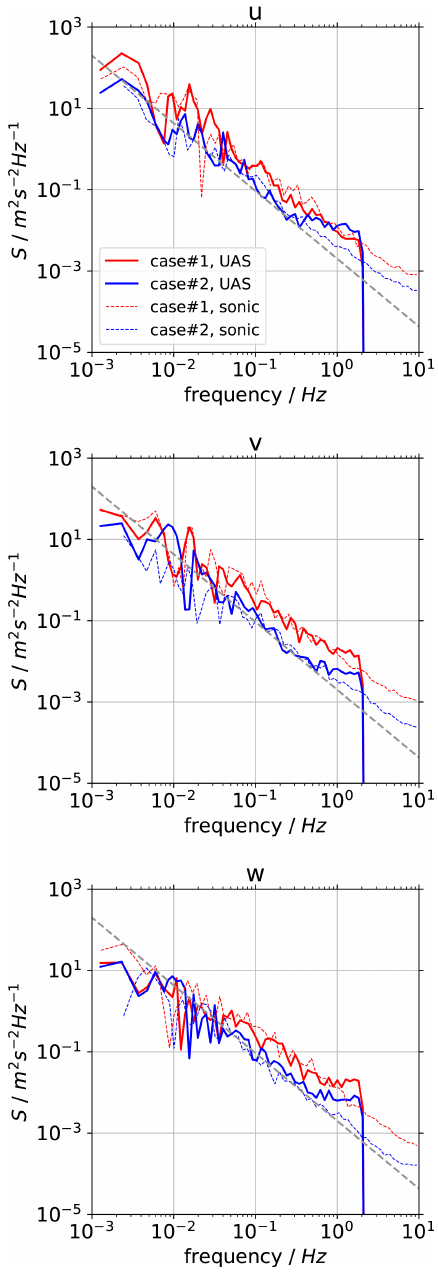
Figure 9. Comparison of power spectra of all three wind compo- nents between sonic anemometers and